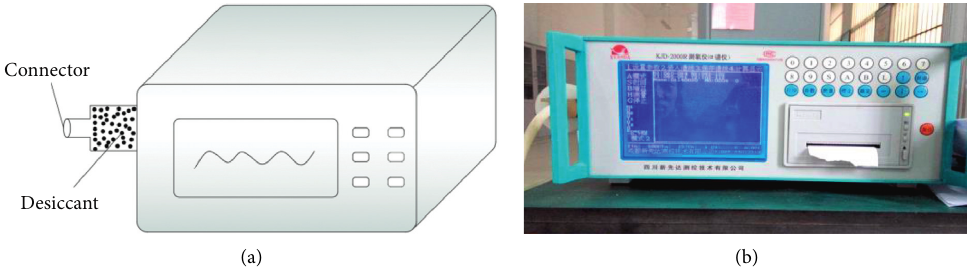
Figure 5: Schematic of the KJD-2000R emanometer: (a) structure shape and (b) physical